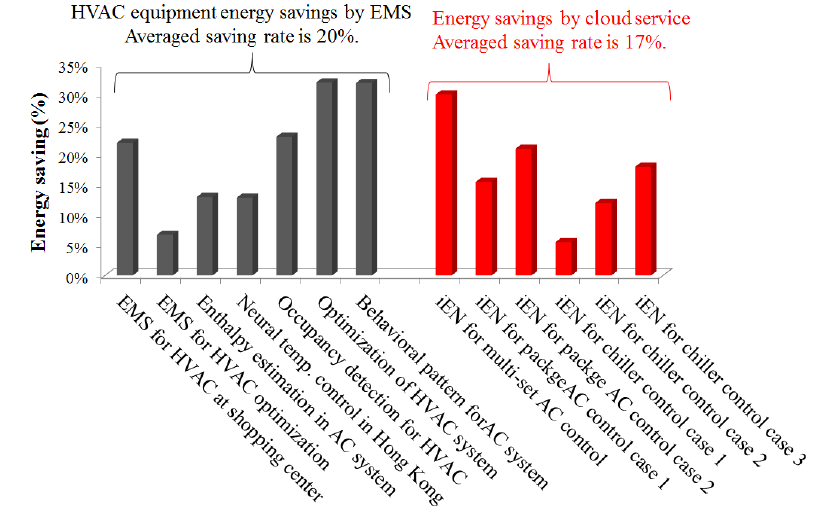
Figure 6. Comparison of energy savings of HVAC equipment by applying EMS and